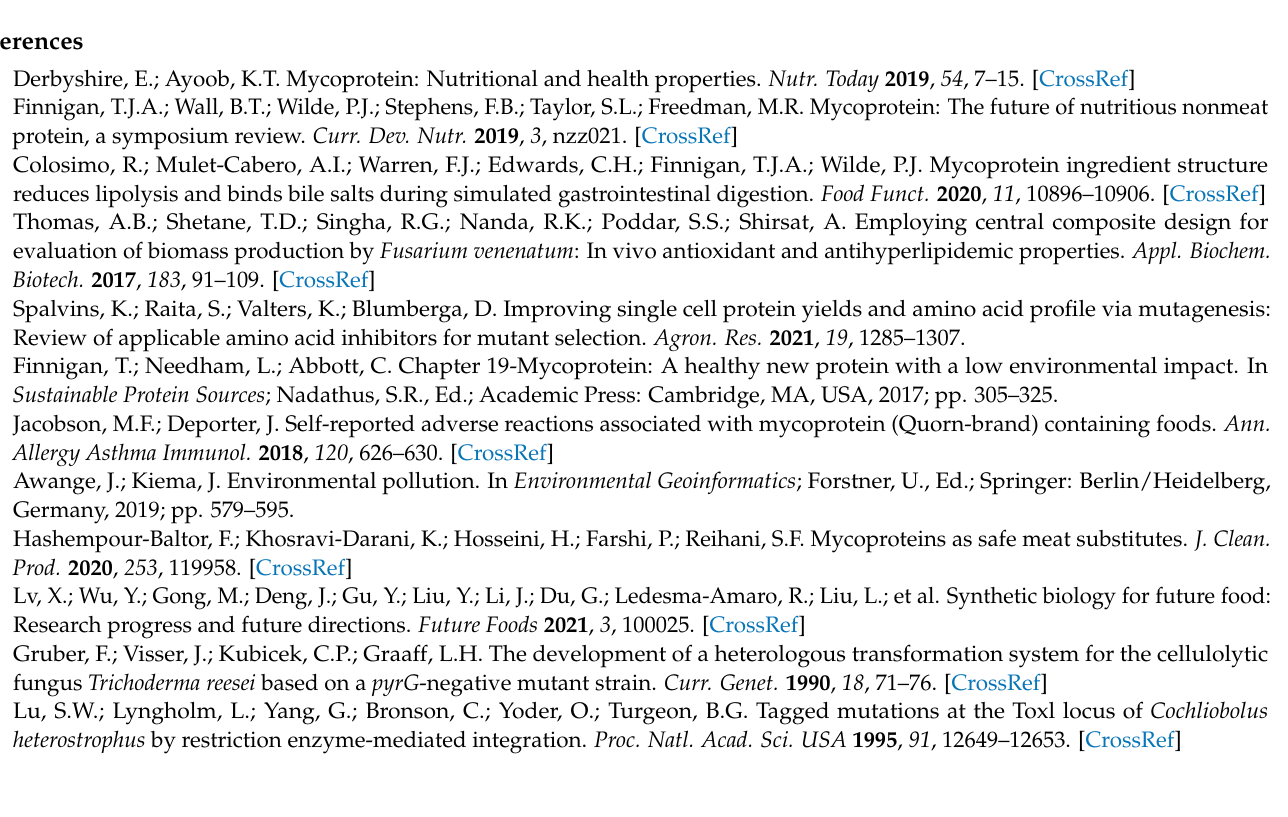
Figure S5. Quantification of the mean fluorescence intensity of fluorescent strains by ImageJ